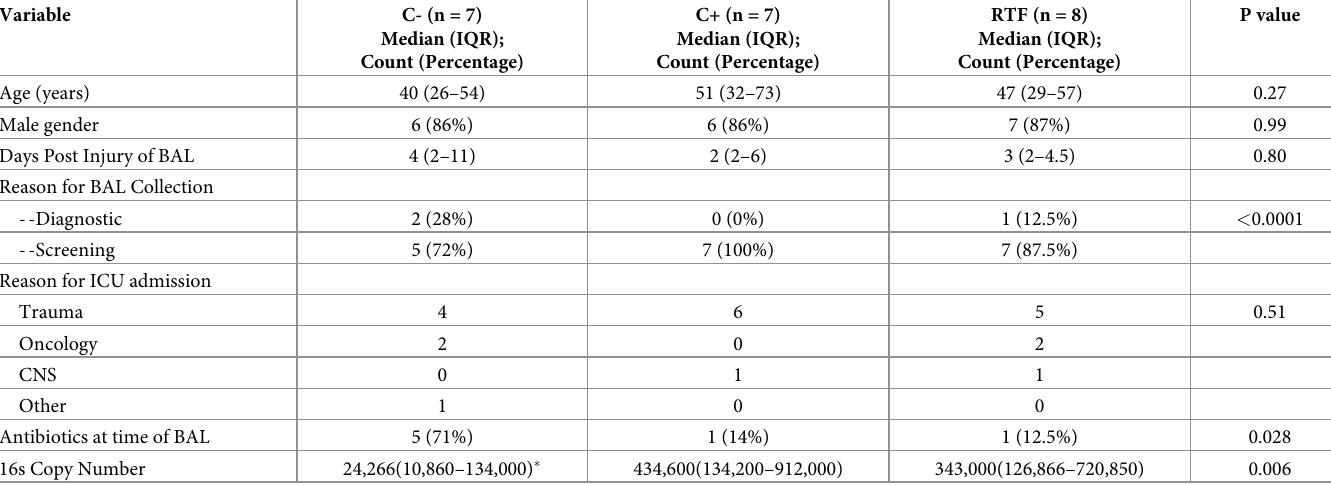
Table 1. Demographic data of bronchoalveolar lavage samples stratified by traditional culture results.